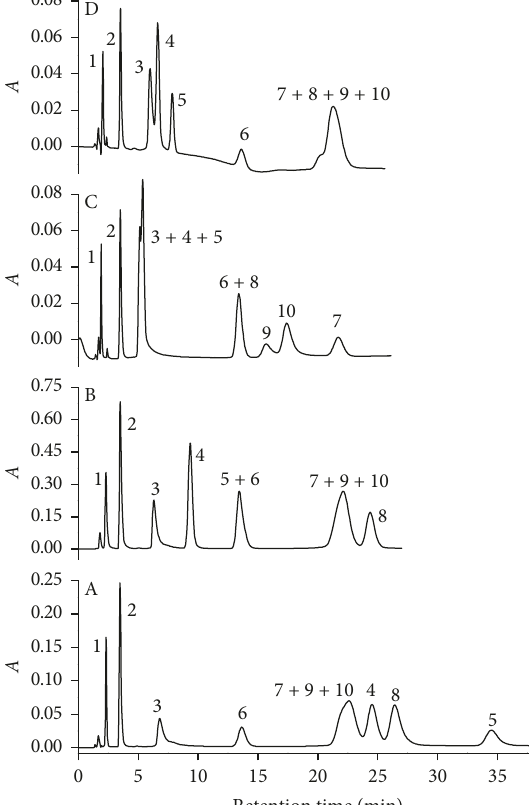
Figure 2: Effect of pH on the analyte separation. pH: (a) 6.0; (b) 7.0; (c) 8.0, and (d) 50% of phase A (pH 7.0) and 50% of phase B (pH 8.0). Data were obtained for standard solution of amoxicillin (1), caffeine (2), tetracycline (3), diclofenac (4), ibuprofen (5), 17 α - ethynylestradiol (6), levonorgestrel (7), nimesulide (8), cipro- floxacin (9), and norfloxacin (10) in the concentration of 1 , with an injected volume of 20 μ L, at a flow rate of 20.0mg L · 1 , at 25 ° C, and detection at 220 nm. Mobile phase 1.0mL min − · contains 15.0% (v/v/) ethanol, 3.0% (m/v) SDS, and 20.0mmol − of phosphate and isocratic elution. A in the y -axis is the